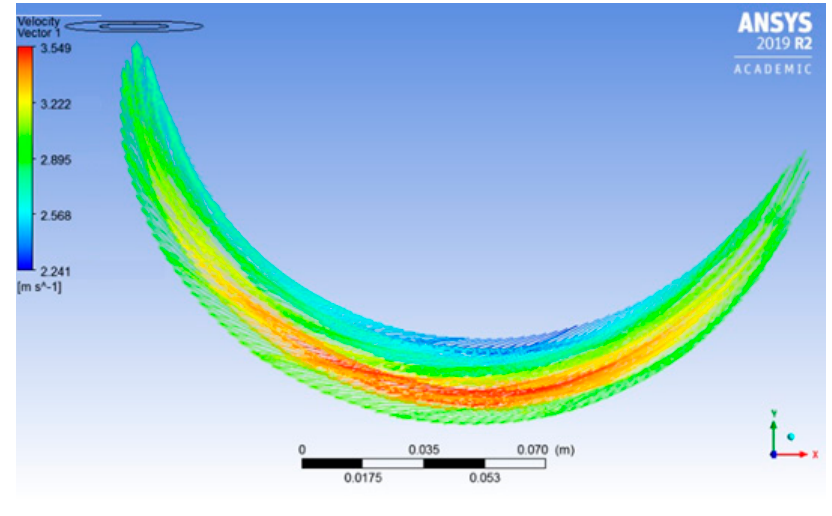
Figure 6. Model of the steam formation process in the coil of a direct ‐ flow steam